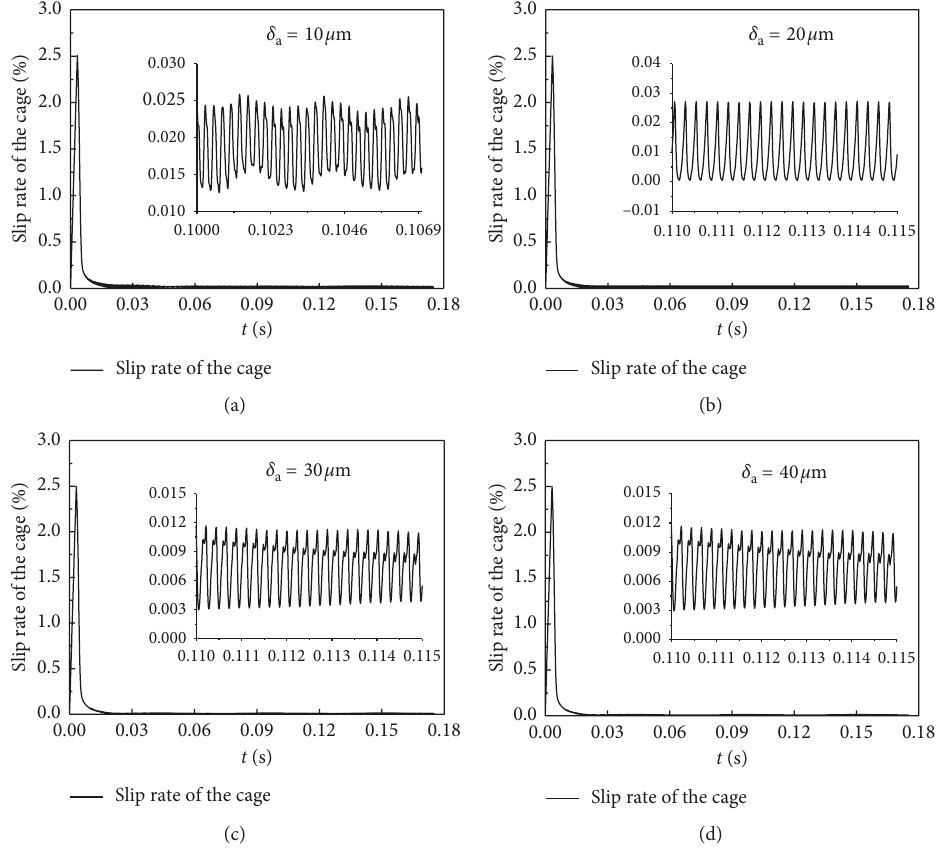
Figure 13: The slip rate of the cage. F